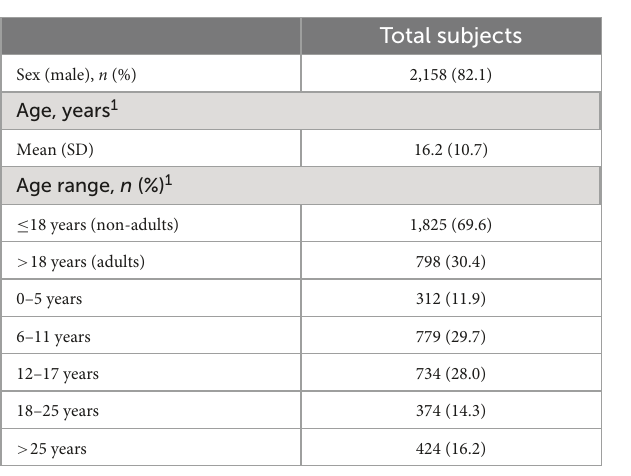
TABLE 1 Sociodemographic characteristics of autism spectrum disorder (ASD).